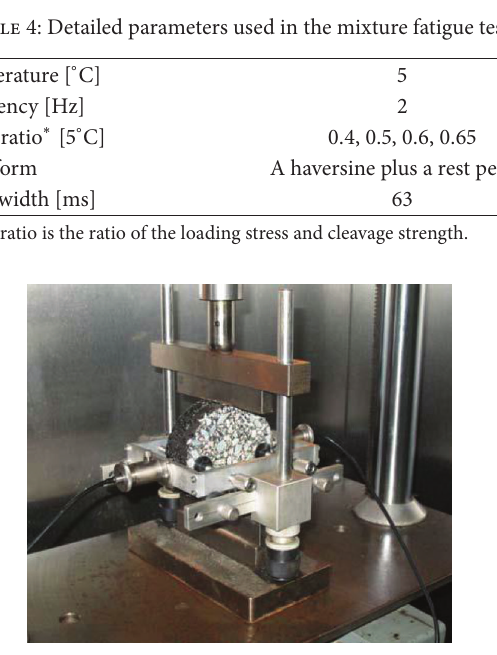
Figure 3: Indirect tensile testing device for the fatigue test and indirect tensile modulus test.